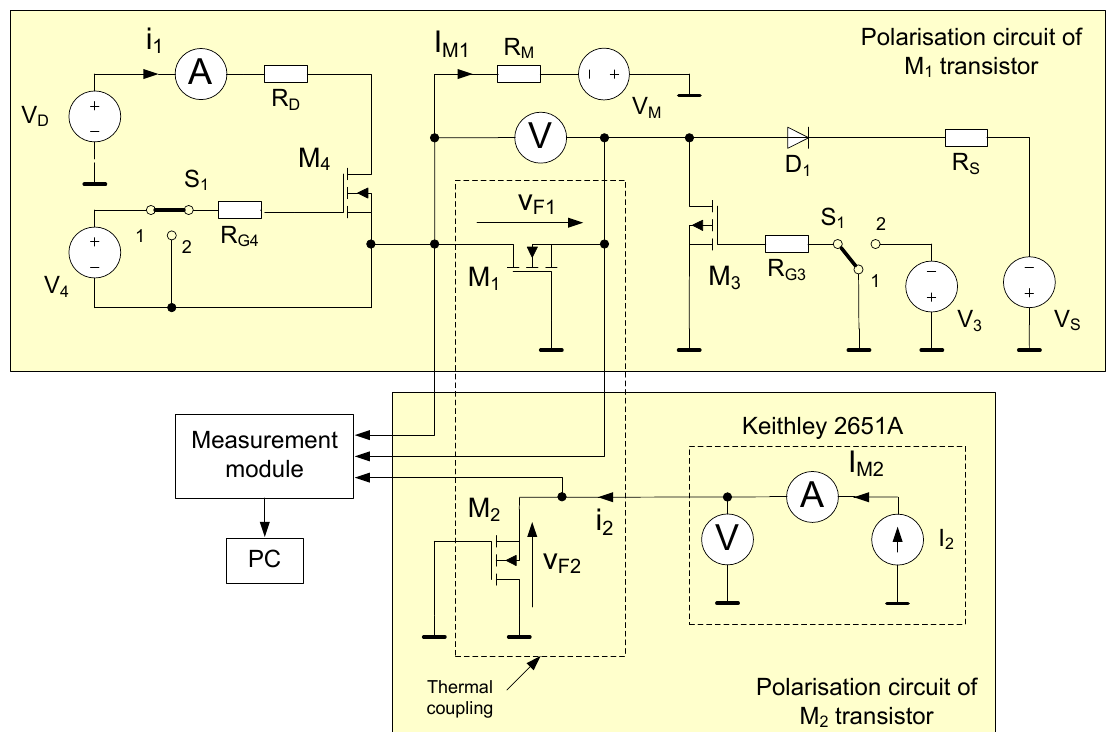
Figure 4. Diagram of the measurement setup for v F as a TSP for M 1. These parameters are: voltage v DS that is proportional to the resistance R DS(on) of the channel of the turned-on M 1 transistor that is operating in the linear range (Figure 2), voltage v GS of the transistor that is operating in the saturation range (Figure 3), and the voltage v F on the forward biased body diode (Figure 4). The measurements of the chip temperature of transistor M 2 in all the cases were carried out only using voltage v F on the forward biased body